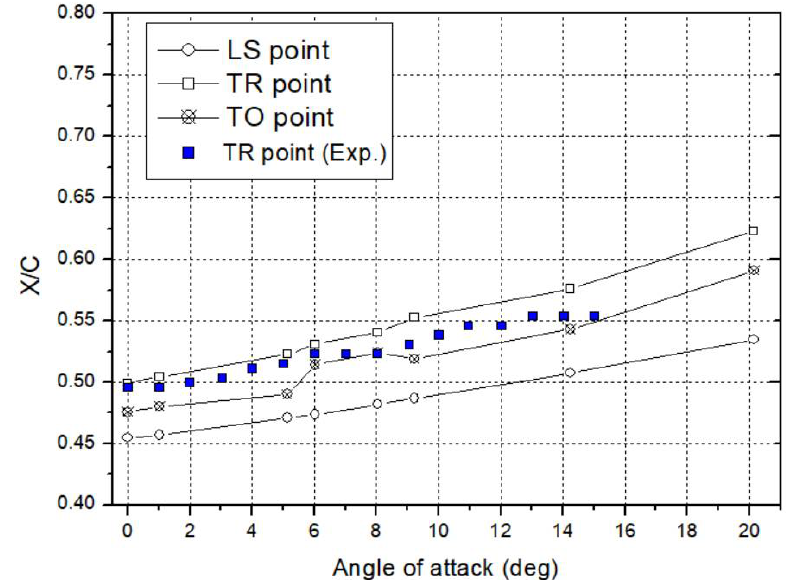
Figure 10. Movement of LS, TR, and TO points on the pressure airfoil surface with increasing AoA. The blue squares represent experimental data points.